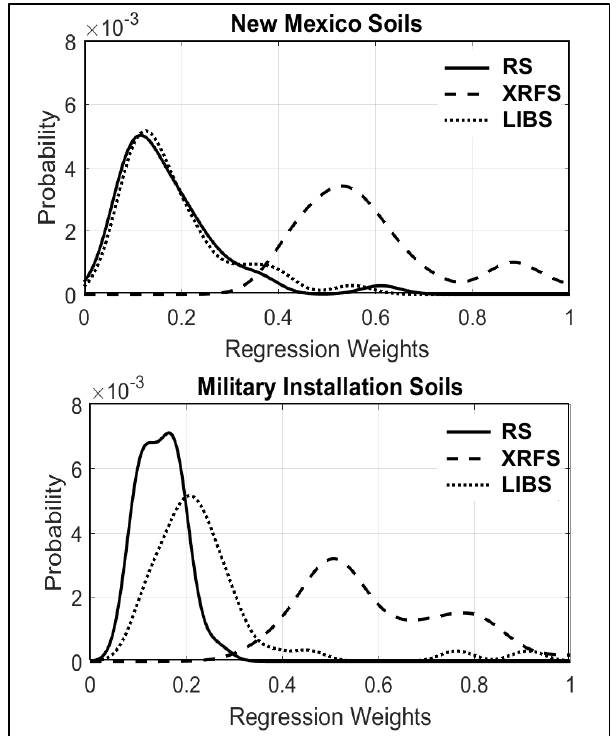
Figure 9. Probability density functions (pdfs) for the PLSDA regression weights applied to the features for the RS, XRFS, and LIBS analyzers for the New Mexico soils (top) and military installation soils (bottom). The absolute value was taken of the regression weights since the magnitude, positive or negative, indicates degree of influence on the classification decision. The weights were also normalized to place the pdfs for the two data sets on the same scale.